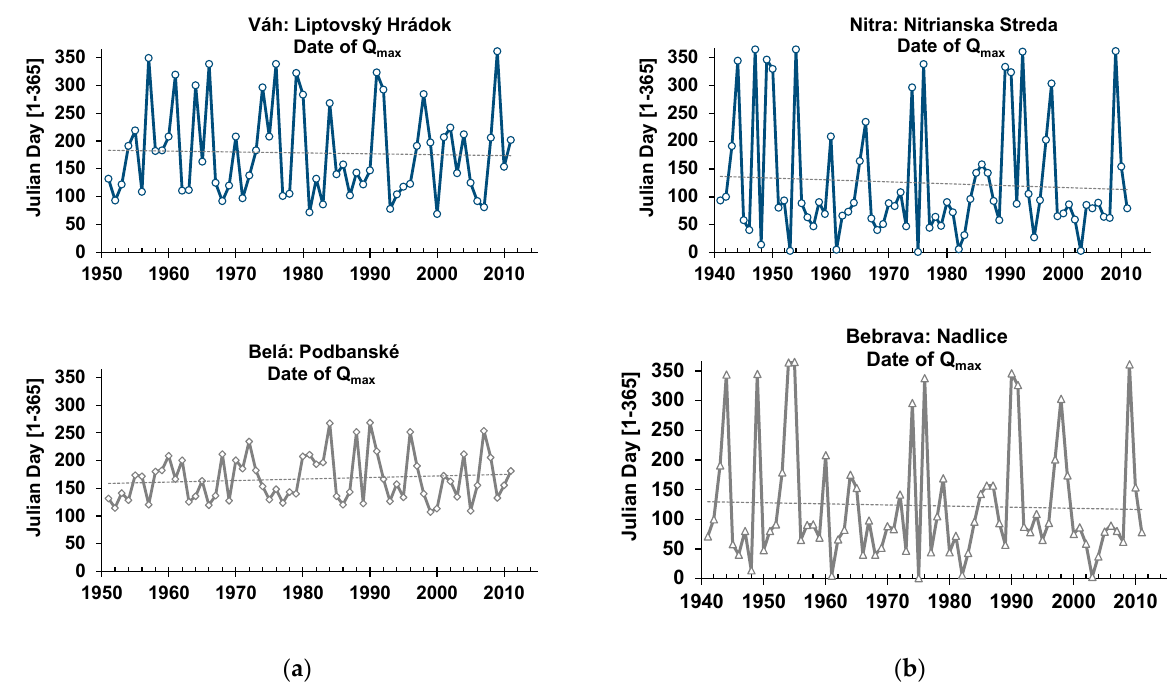
Figure 3. Occurrence of the annual maximum discharges in Julian days for ( a ) Váh: Liptovský H á dok (1950–2011) and Bel á : Podbansk é (1950–2011); ( b ) Nitra: Chynorany (1940–2011) and Bebrava: Nadlice (1940–2011). Table 1. Selected mainstreams and their tributaries, stations, analyzed periods, annual maximum discharge, river kilometer, and basin